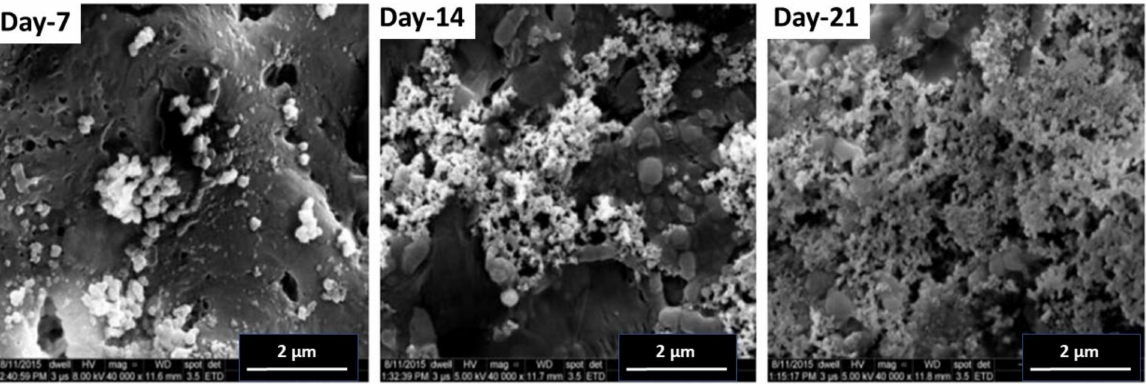
Figure 10. FESEM analysis after the Simulated Body Fluid Assay at different time intervals of 7, 14, and 21 days for PHB + 5 wt%